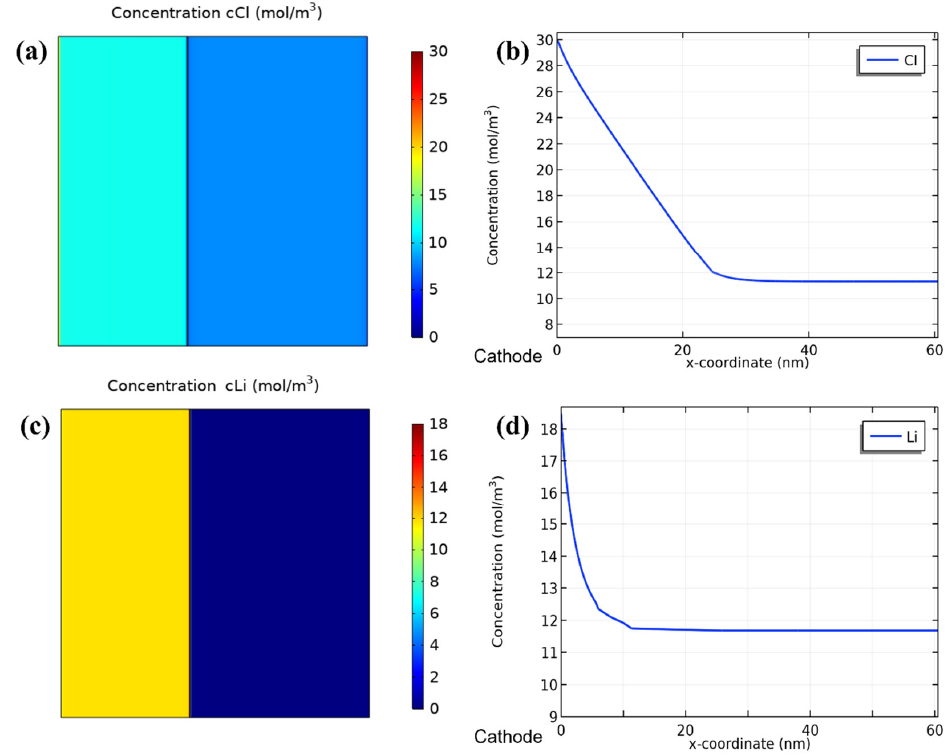
Figure 7. Simulated concentration distributions of chloride ions ( a ) in the device and ( b ) near the cathode after 20 h of deionization with an applied voltage of 1.0 V and an initial NaCl concentration of 10 mM; ( c , d ) the corresponding simulated concentration distributions of lithium ions.